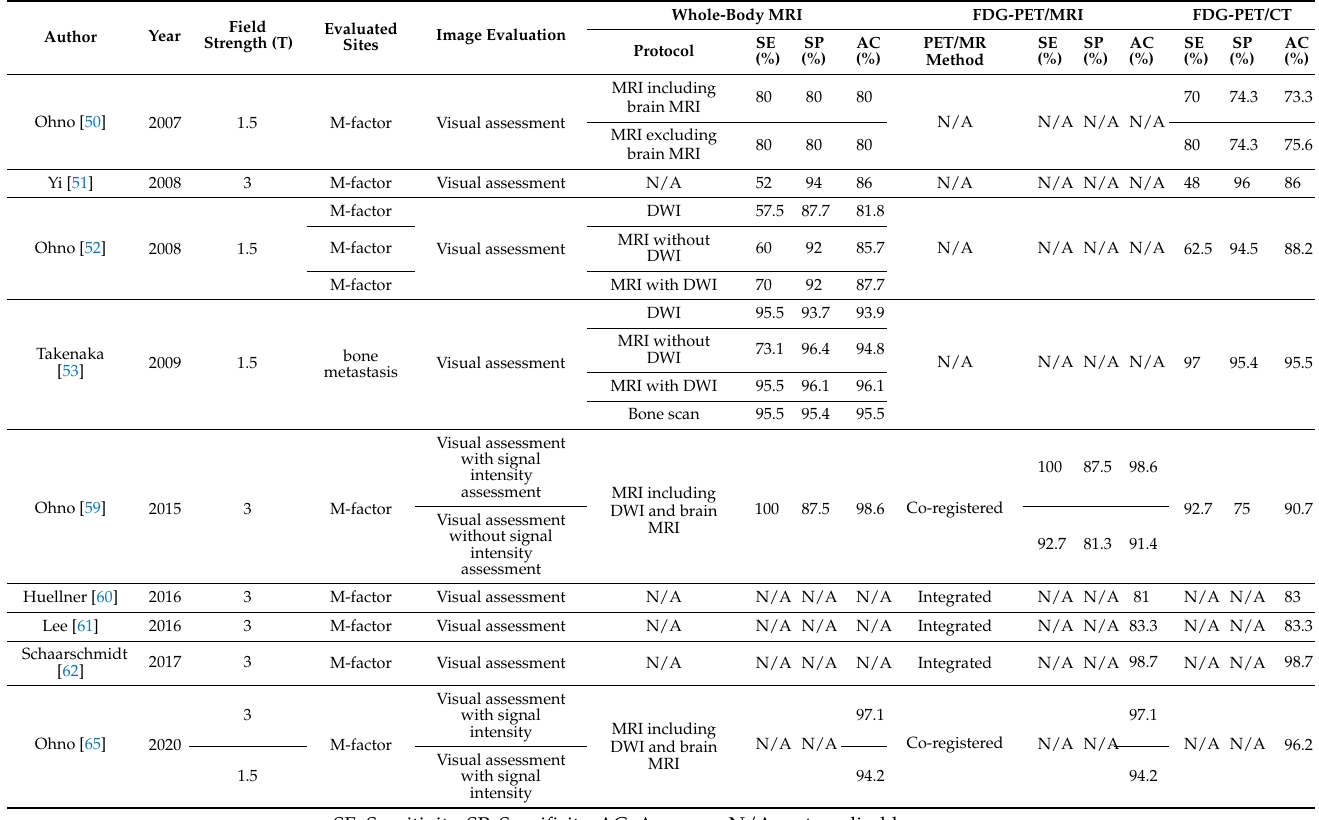
Table 7. Summary of diagnostic performance of M-factor assessment using whole-body MRI or